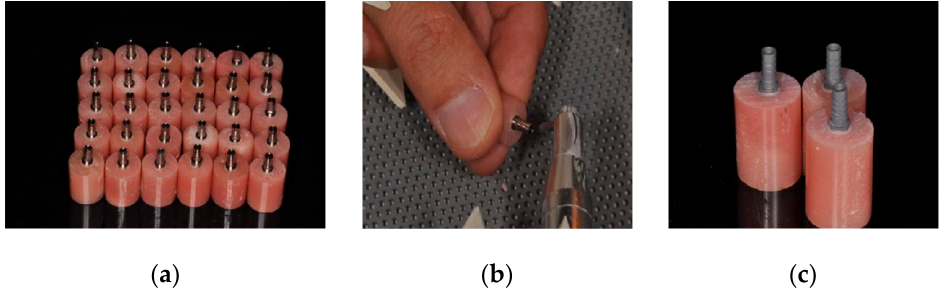
Figure 1. Preparation of samples: ( a ) implant insertion into the resin supports, ( b ) sandblasting of abutments, and ( c ) evidence of the sandblasting process.